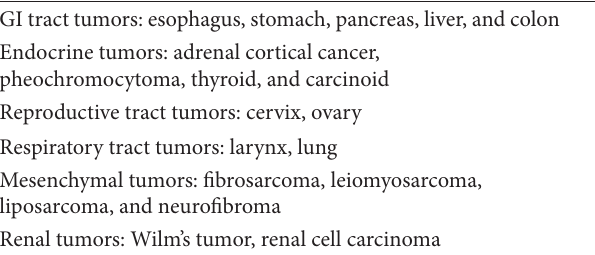
Table 1: Tumors associated with NICTH.